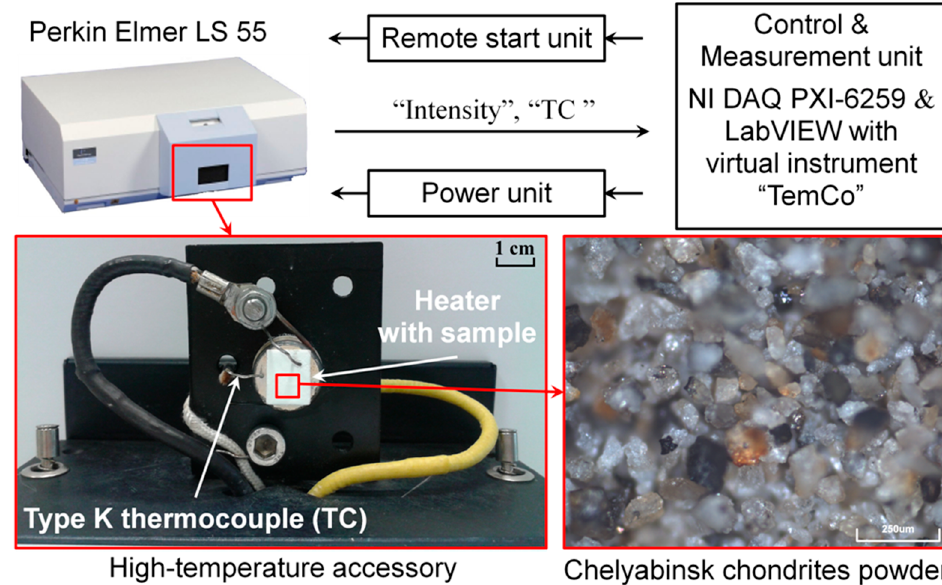
Figure 1. Thermoluminescent spectrometer.